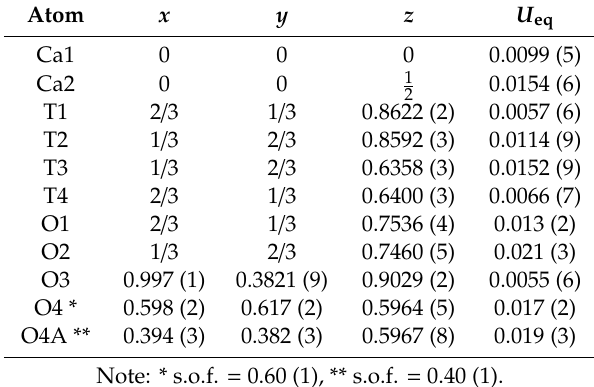
Table 2. Atomic coordinates, isotropic atom displacement parameters (Å 2 ), and site-occupation factors (s.o.f.) for dmisteinbergite.